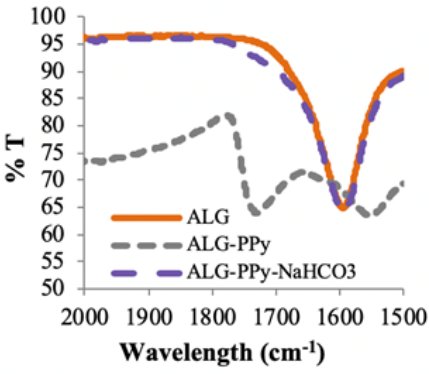
Figure 1. FTIR data of the carbonyl region showing alginate, PPy–Alg, and PPy–Alg reacted in the presence of NaHCO 3 .